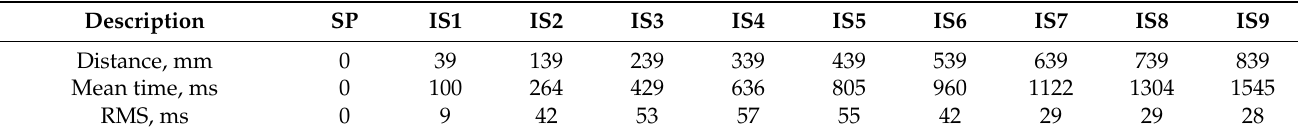
Table 3. Data for the time–distance